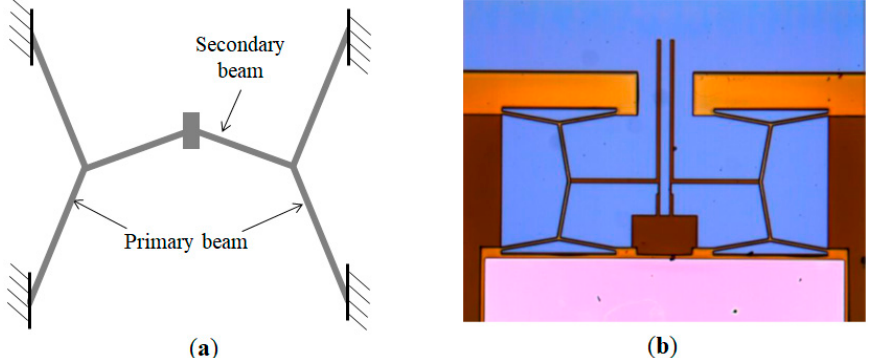
Figure 7. Cascaded chevron actuator: ( a ) schematic; ( b ) microgrippers [88].